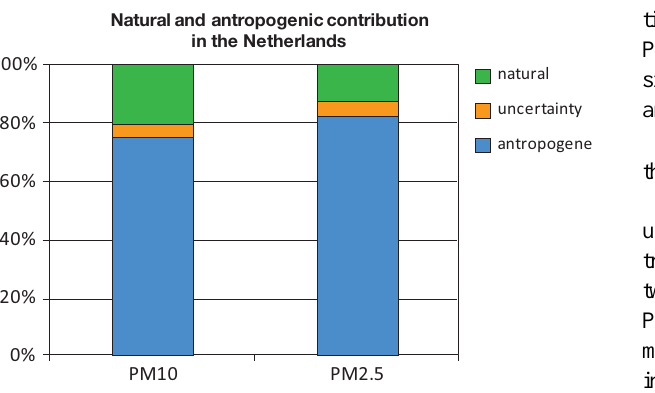
Fig. 6. Natural and anthropogenic contributions to PM 10 and PM 2 . 5 as estimated from the BOP data